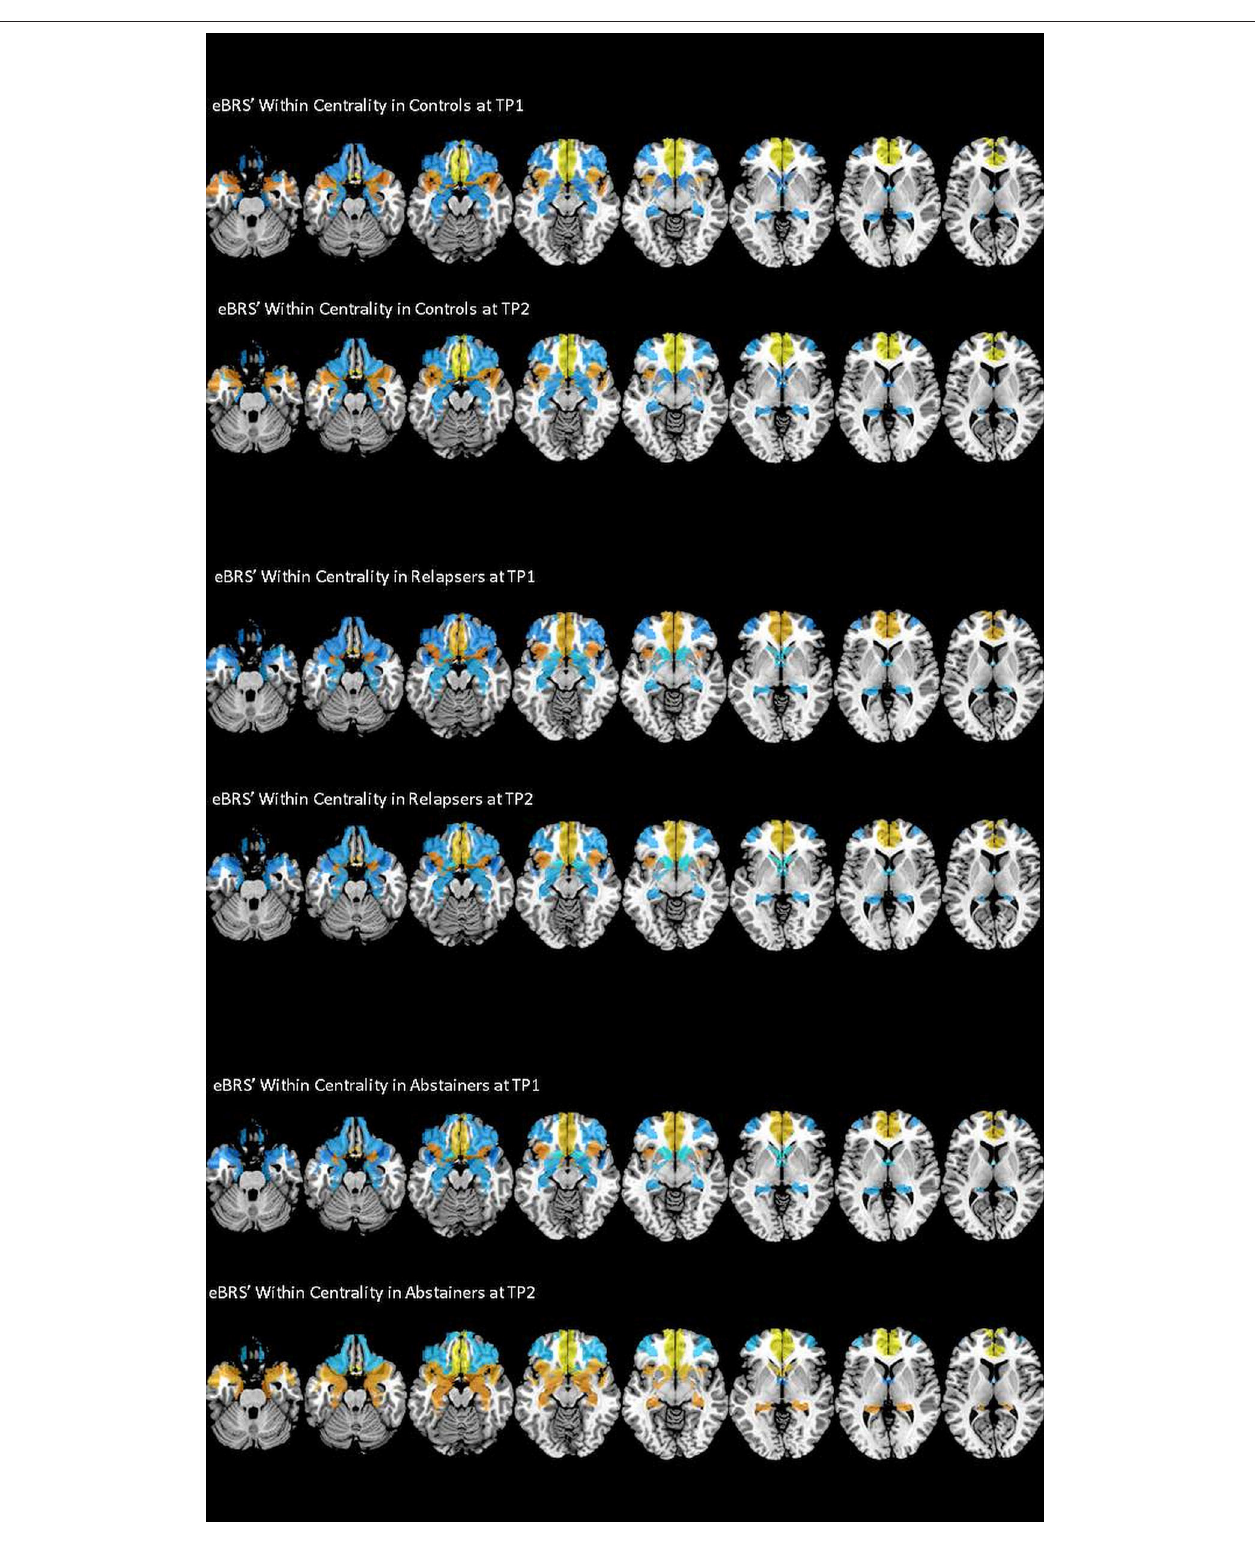
FIGURE 4 | Within Centrality of the nine eBRS regions at 1 month into abstinence ad 3 months later. eBRS regions with a positive Within Centrality value are coded in orange – yellow (range 0–0.8) and eBRS regions with a negative Within Centrality value are coded in blue – light blue (range 0–1). Relapsers had generally lower Within Centrality values than the two other groups at both timepoints, abstainers showed significantly higher Within Centrality values in subcortical regions, especially in the hippocampus and nucleus accumbens, than controls and relapsers at the 3 months follow-up.